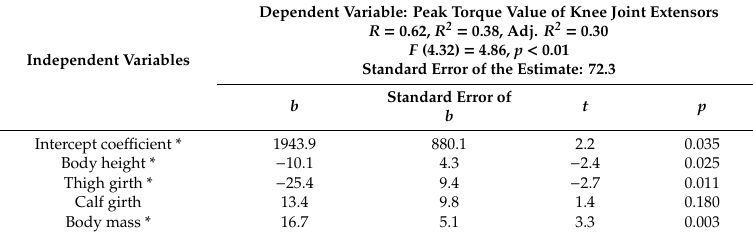
Table 4. Results of regression analysis for knee joint extensor torque.